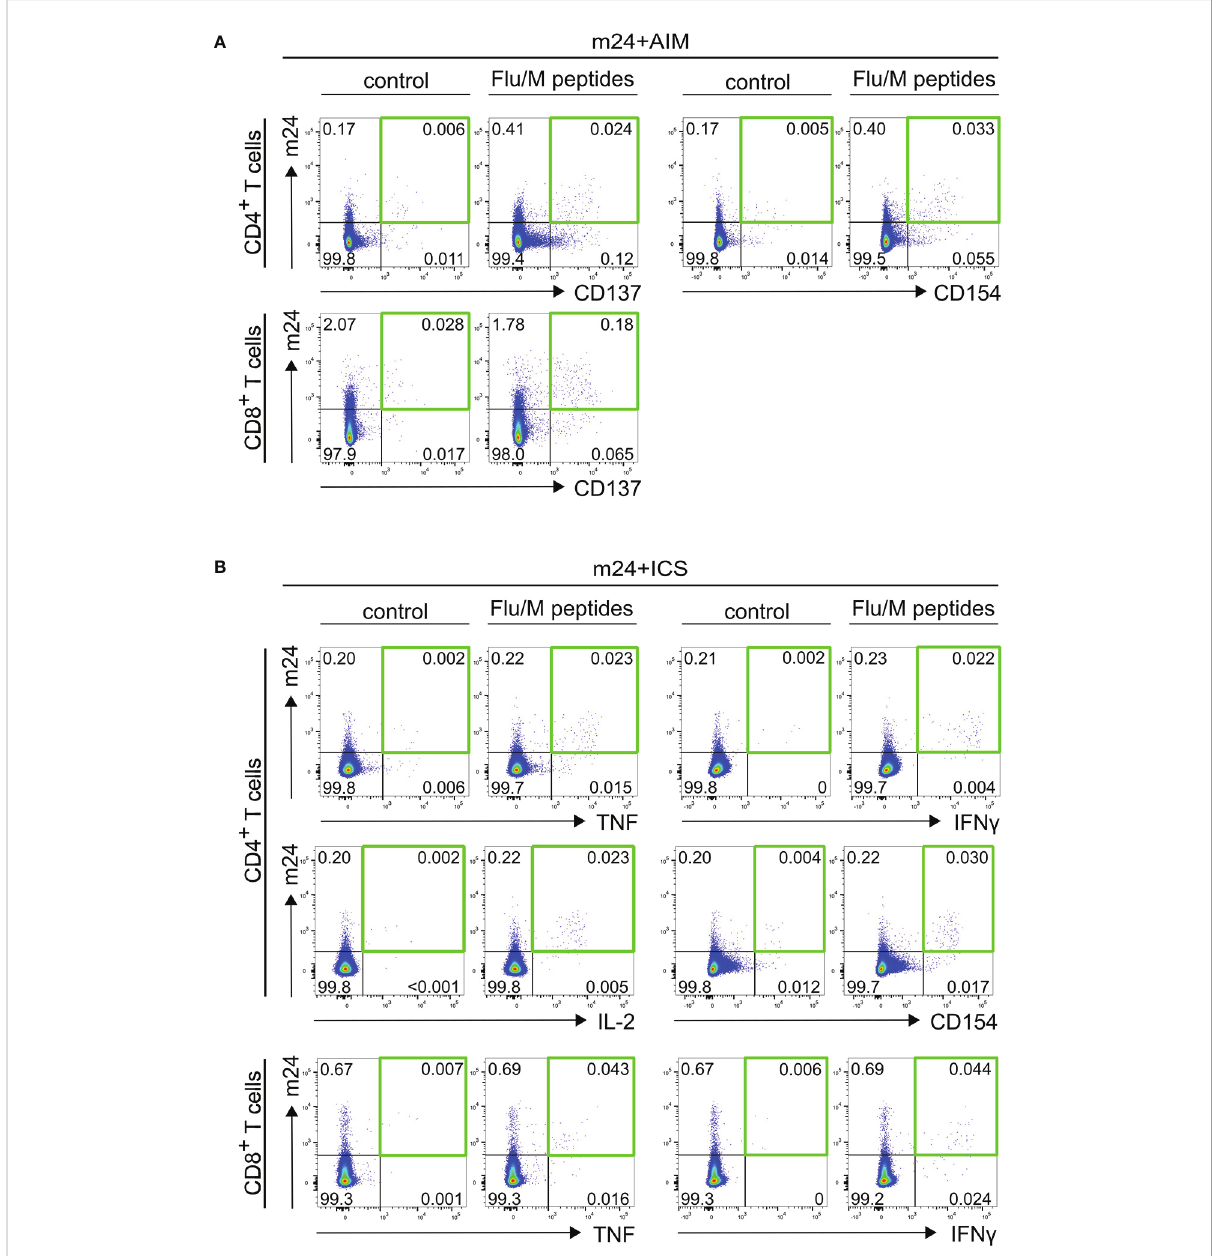
FIGURE 2 Detection of antigen-speci fi c T cells using m24+AIM (A) or m24+ICS (B) . Exemplary dot plots of PBMCs from donor HD6 incubated with Flu/M overlapping peptides or left unstimulated for 14 h in the presence of CD40 Ab (m24+AIM) or brefeldin A and monensin (m24+ICS). (A) m24+AIM: m24 Ab staining in combination with CD137 or CD154 expression on CD4 + T cells, or m24 Ab staining and CD137 expression on CD8 + T cells (B) m24+ICS: m24 Ab staining in combination with intracellular TNF, IFN g , IL-2 and CD154 expression for CD4 + T cells, or intracellular TNF and IFN g expression for CD8 + T cells. Numbers represent frequencies within CD4 + or CD8 + T cells. The green squares in (A, B) mark the populations of interest co-expressing two